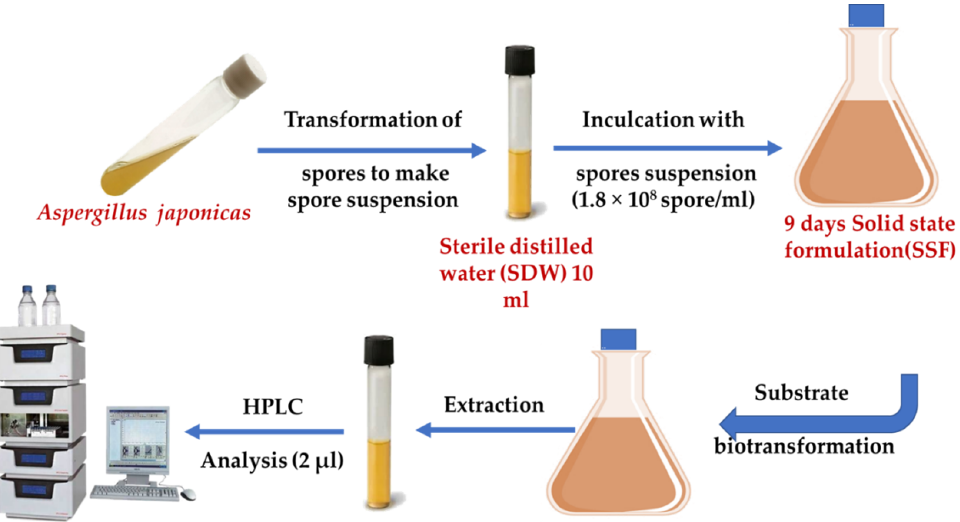
Figure 1. A graphical presentation of the bioconversion of some agro-residues into organic acids by Aspergillus japonicus .